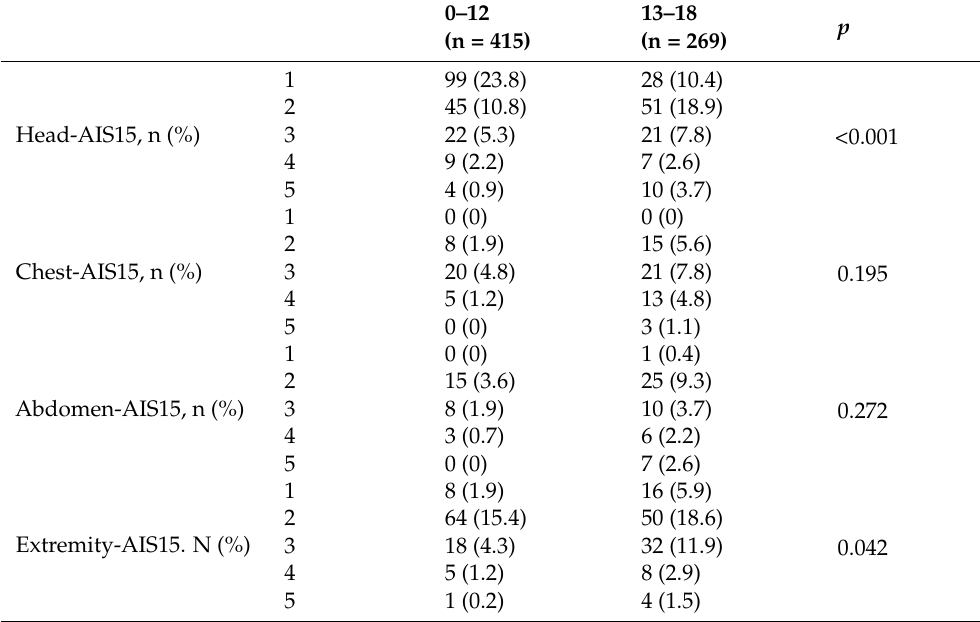
Table 5. Anatomical distribution and severity of trauma: 0–12 years vs. 13–18 years